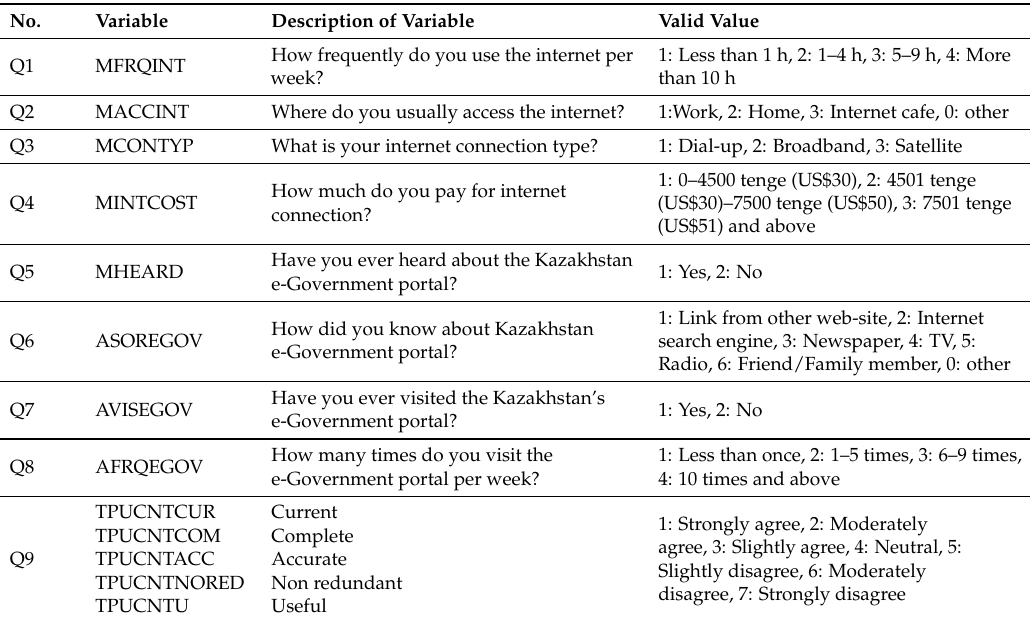
Table A1. Data coding (part